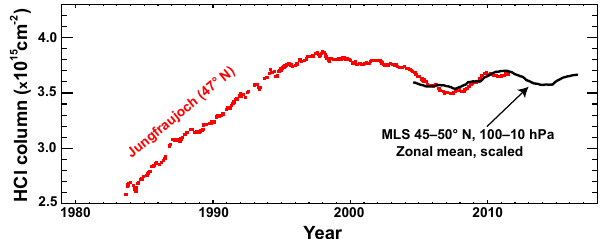
Figure 1. Total column measurements of HCl above Jungfraujoch (latitude = 46.5 ◦ N) smoothed with a 3-year running mean as shown by Mahieu et al. (2014) (red curve). Also shown are the 3-year run- ning mean smoothed zonal mean of measurements of the lower- stratospheric column of HCl (100–10hPa) from the MLS instru- ment on Aura for the latitude band from 45 to 50 ◦ N (black curve). The MLS measurements are of partial column and have been scaled upward to match the Jungfraujoch FTIR measurements for better visual comparison.